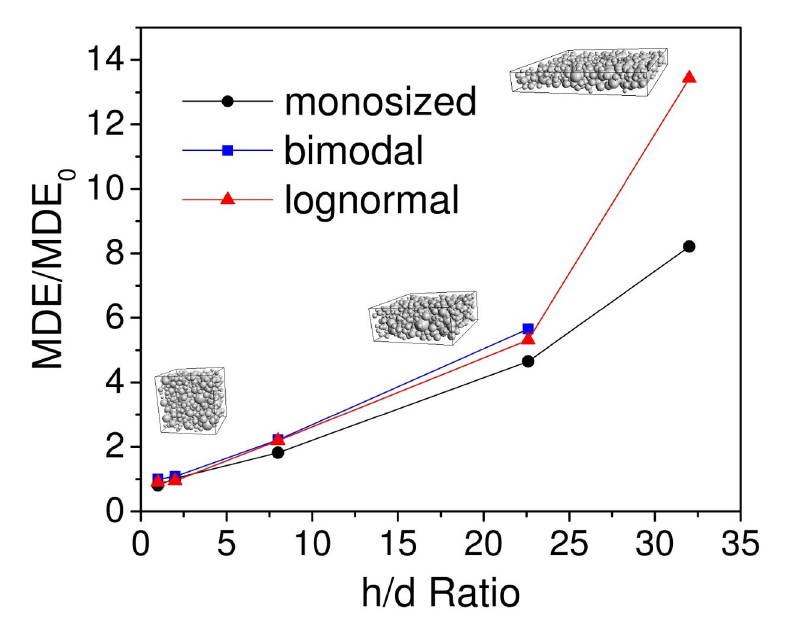
Figure 13. Increase of MDE value with increase of h/d ratio of the sample. h—side of capacitor (sample width); d—thickness of the sample (distance between the capacitor planes). MDE 0 is the value of effect for the sample of cubic shape (h/d = 1).